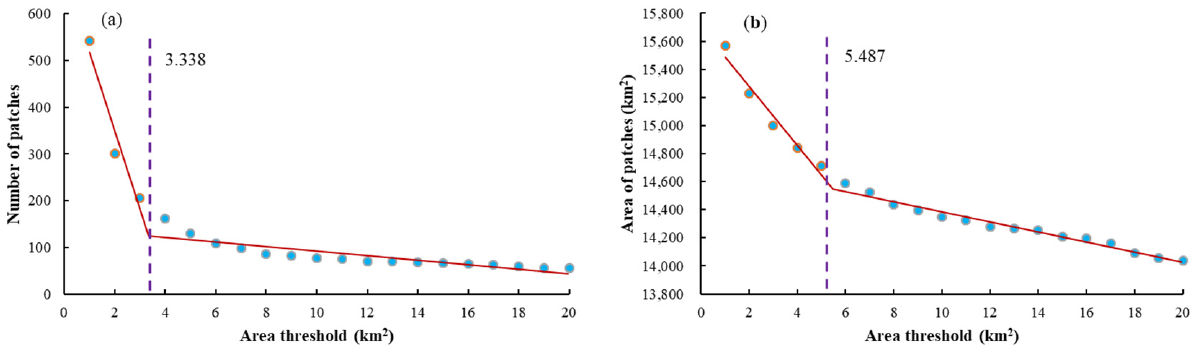
Figure A2. Number ( a ) and area ( b ) of ecological sources under different area thresholds in 2010.